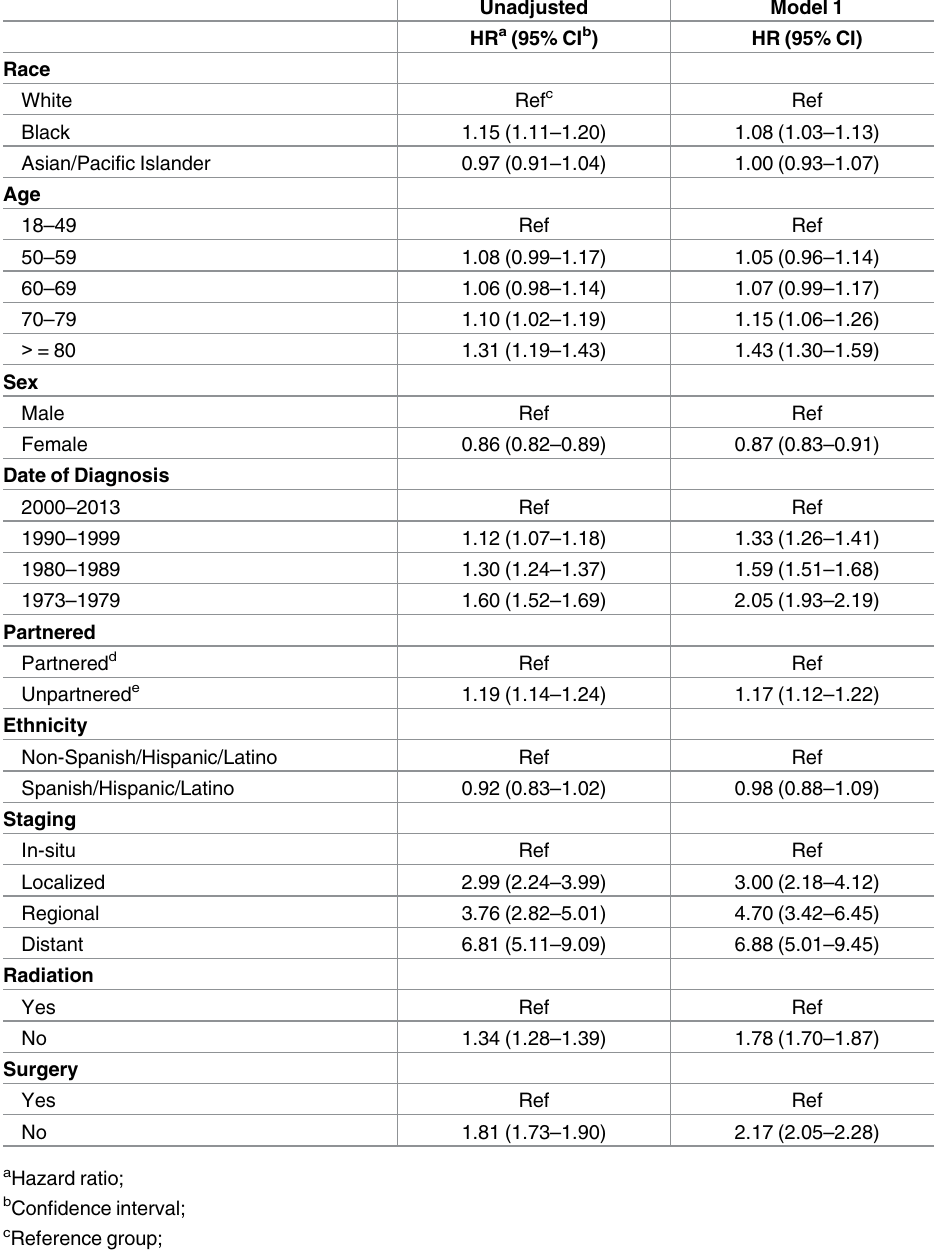
Table 2. Unadjusted and adjusted hazard ratios for cause-specific survival among adult patients in the SEER database diagnosed esophageal squamous cell carcinoma, 1973 and